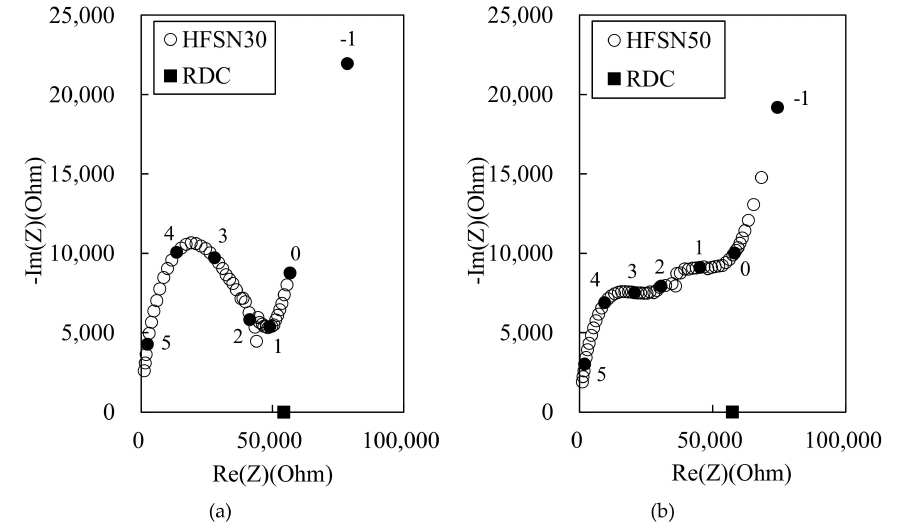
Figure 9. Experimental Nyquist plot for 180 MPa-HPFRCC with MWCNT solution at ( a ) 30% and ( b ) 50% replacement of mix water.